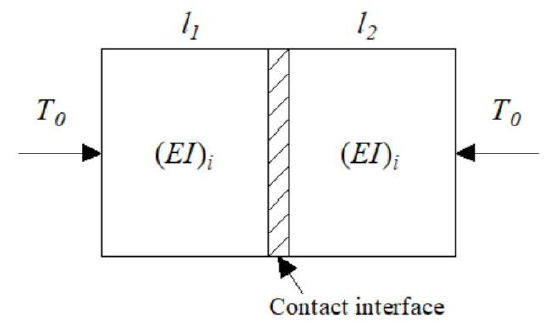
Figure 1. The ith elastic shaft segment with the contact interface.